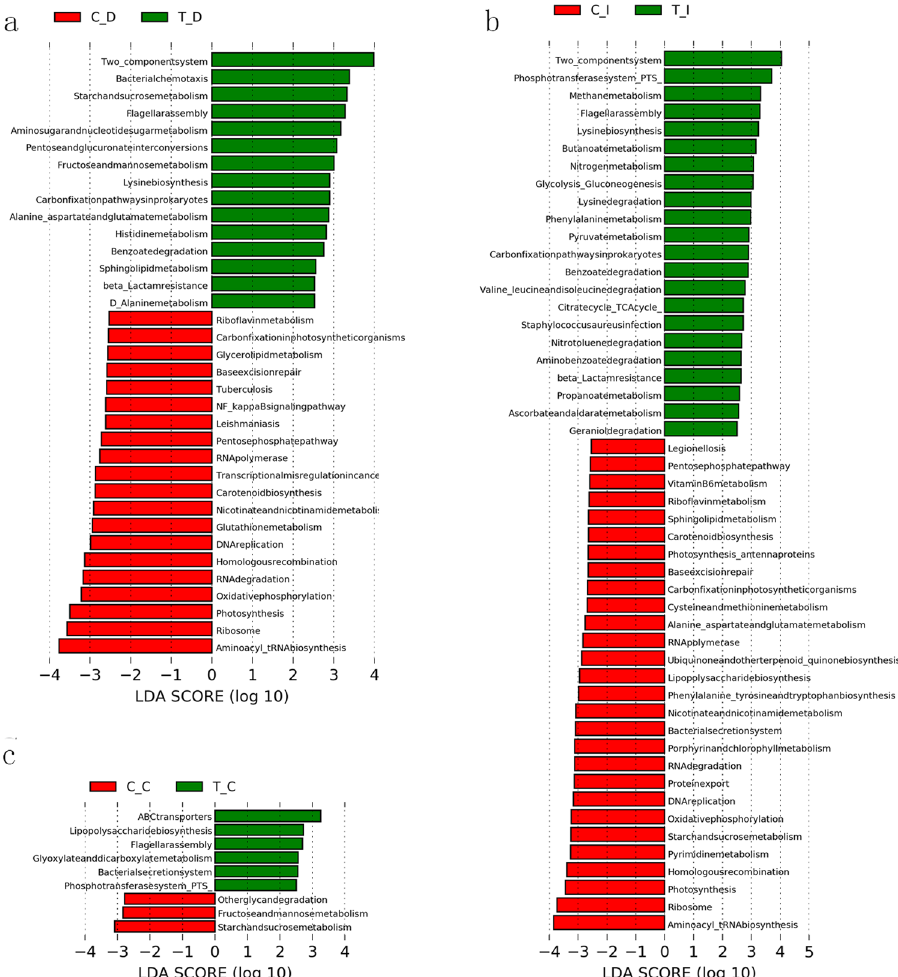
functional genes between the duodenum ( a ), ileum ( b ), and cecum ( c ) samples of the RLF and RPMF